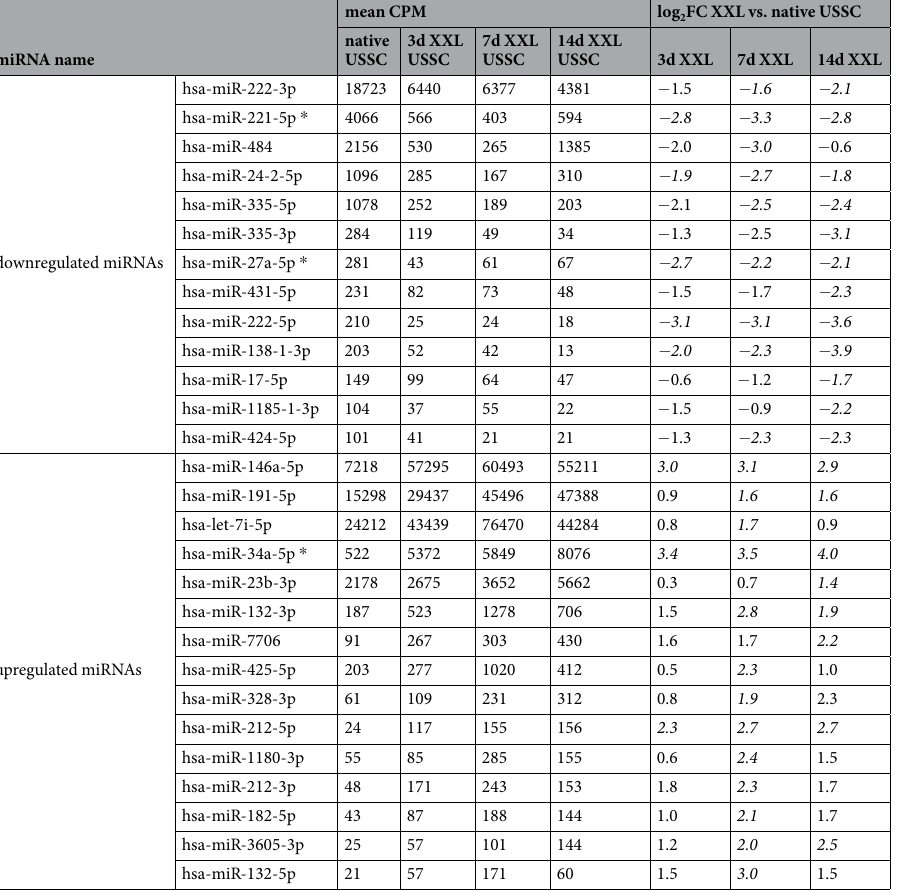
Table 1. Expression pattern of significantly regulated miRNAs. Summary of miRNAs downregulated from a mean CPM value > 100 (upper part of the table) and upregulated to a mean CPM value > 100 at any time point of XXL incubation (lower part of the table). In XXL-USSC, 13 miRNAs were downregulated from a mean CPM value > 100 from which five miRNAs were significantly reduced at all three investigated time points of